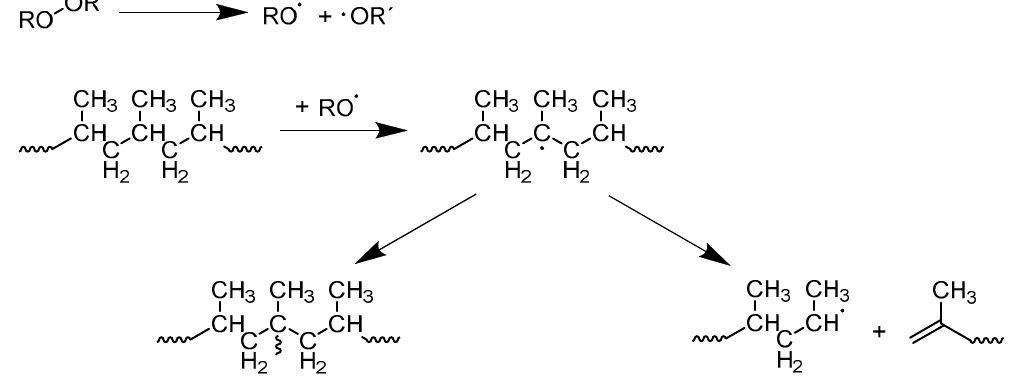
Figure 1. Reaction scheme of long-chain branching (LCB) confronted with β -scission of polypropylene (PP).